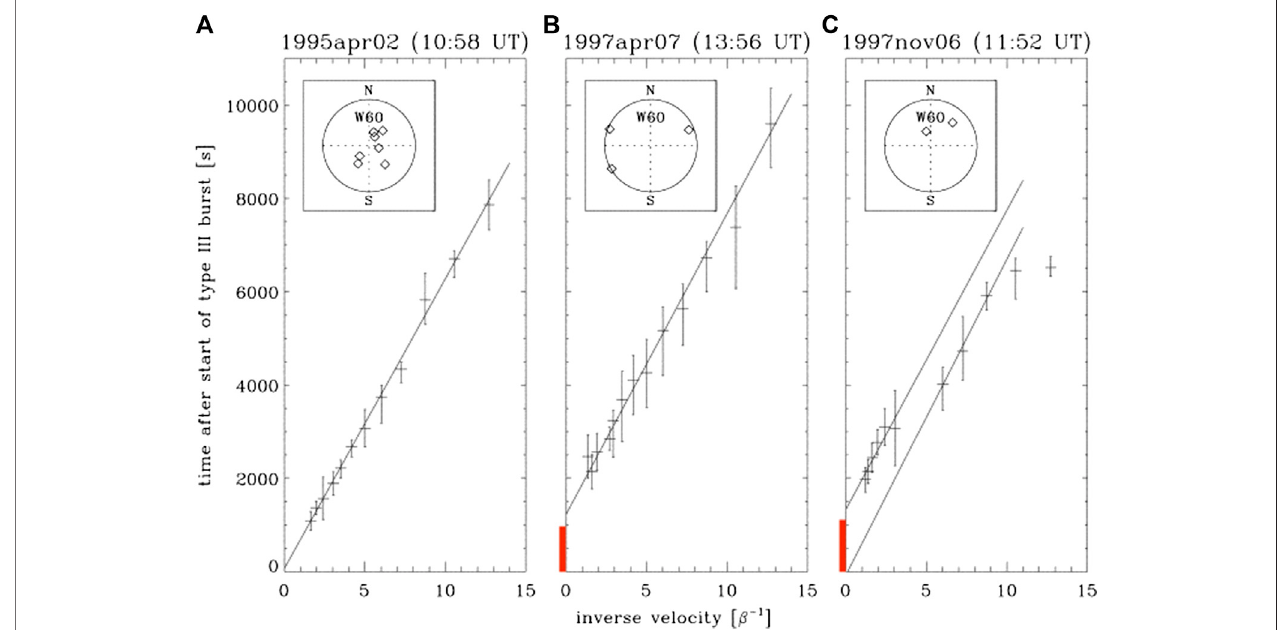
FIGURE 3 | Velocity dispersion analysis of three impulsive electron events showing different timing with respect to the start of the decametric type III bursts. The verticalaxisshows theonsetdelaywith respecttothestart ofthetype IIIburst group: (A) simultaneousrelease ofelectrons at energiesupto80keV; (B) delayedrelease of electrons at all energies; (C) simultaneous release of low-energy electrons below ∼ 30 keV, and delayed release of electrons at higher energies. The position of the associated fl are is shown in the insets with respect to a position in the ecliptic plane at 60 ° W. From Krucker et al. (1999). ©AAS. Reproduced with permission. The red vertical bars in (B) and (C) are estimated durations of the type III burst groups, based on the dynamic spectra in Reiner et al.